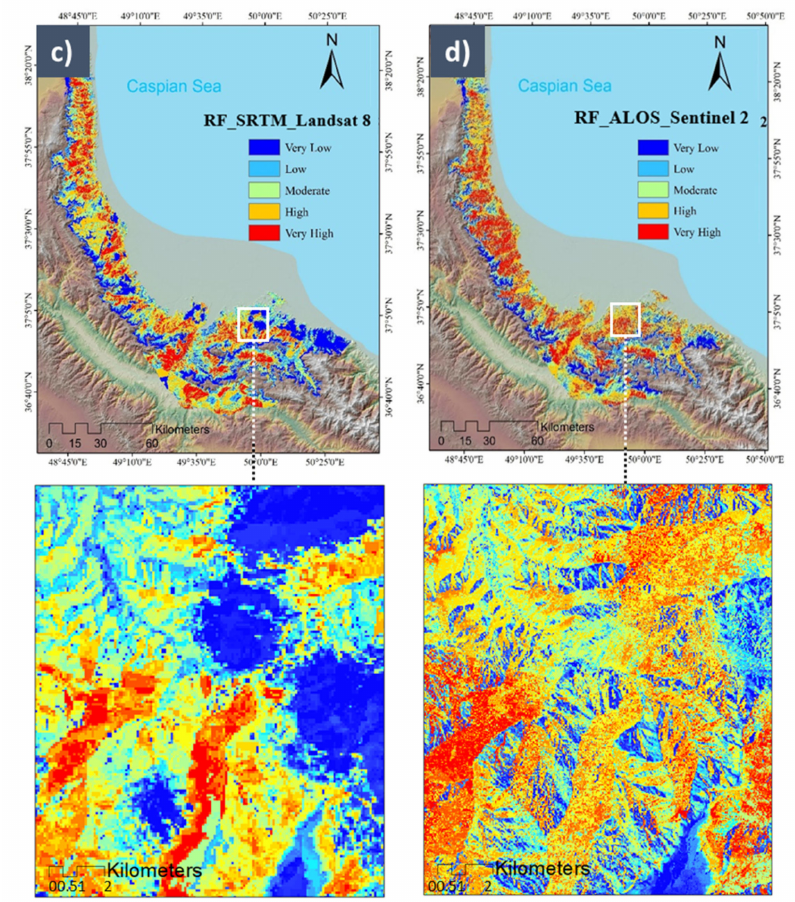
Figure 10. The resulting wildfire susceptibility prediction (WSP) maps from ( a ) SVM 30 , ( b ) SVM 10 , ( c ) RF 10 , ( d ) RF 30